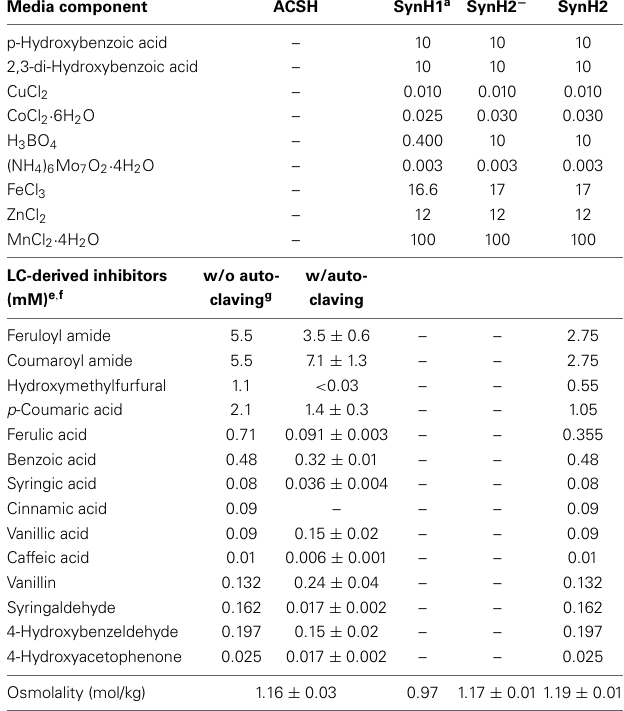
Table 1 | Composition of ACSH, SynH1, SynH2 − , and SynH2. Media component ACSH SynH1 a SynH2 − SynH2 CARBOHYDRATES (mM) a